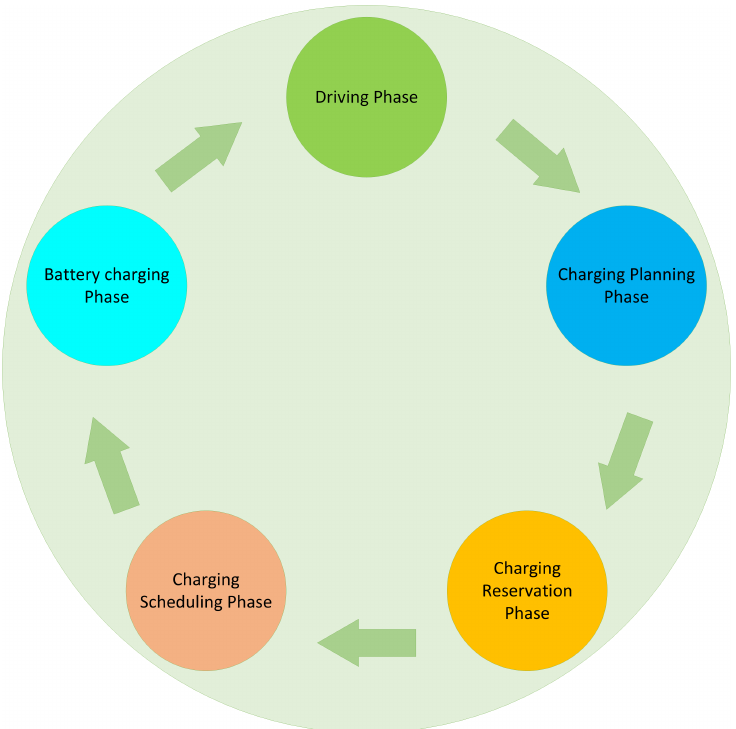
Figure 4. System cycle of EV in on-the-move mode charging management